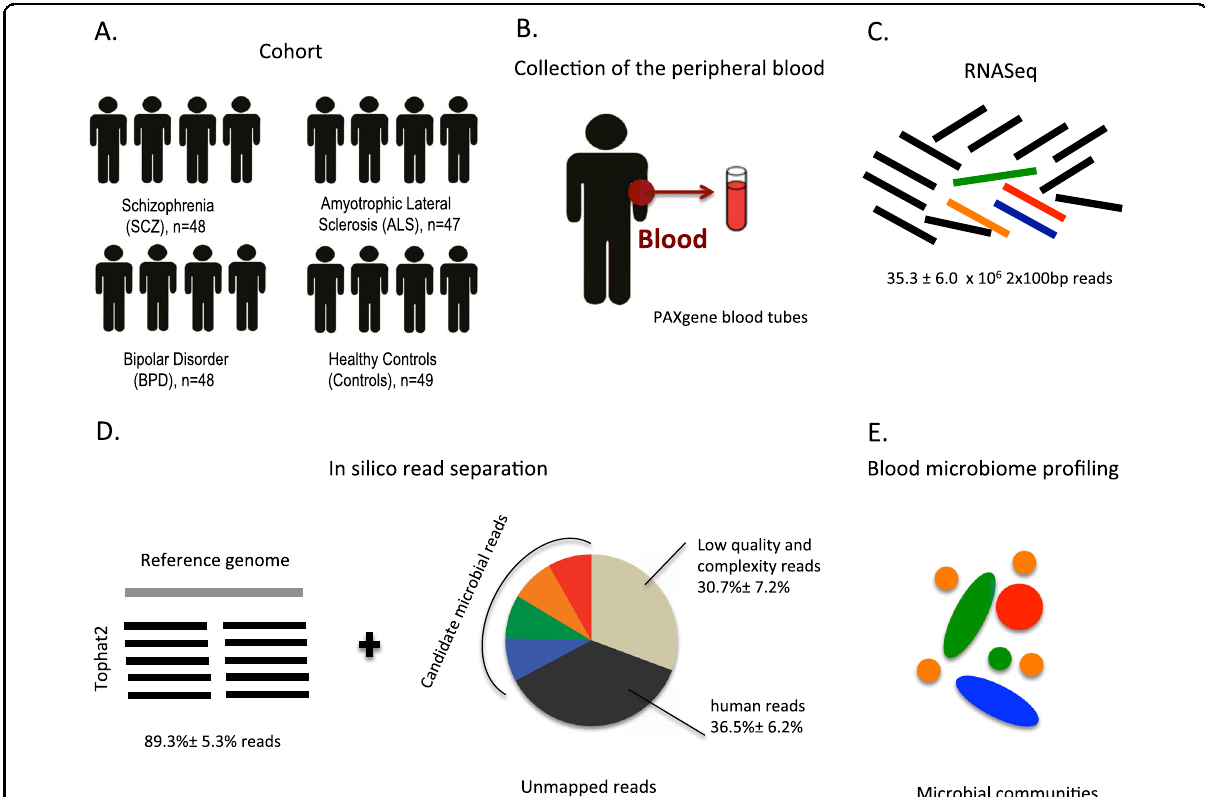
Fig. 1 Microbial pro fi ling using RNA-Seq data from whole blood. a We analyzed a cohort of 192 individuals from four subject groups, i.e. Schizophrenia (SCZ, n = 48), amyotrophic lateral sclerosis (ALS n = 47), bipolar disorder (BPD n = 48), unaffected control subjects (Controls n = 49). b Peripheral blood was collected for RNA collection. c RNA-Seq libraries were prepared from total RNA using ribo-depletion protocol. d Reads that failed to map to the human reference genome and transcriptome were sub-sampled and further fi ltered to exclude low-quality, low complexity, and remaining potentially human reads. e High quality, unique, non-host reads were used to determine the taxonomic composition and diversity of the detected microbiome. See also Table